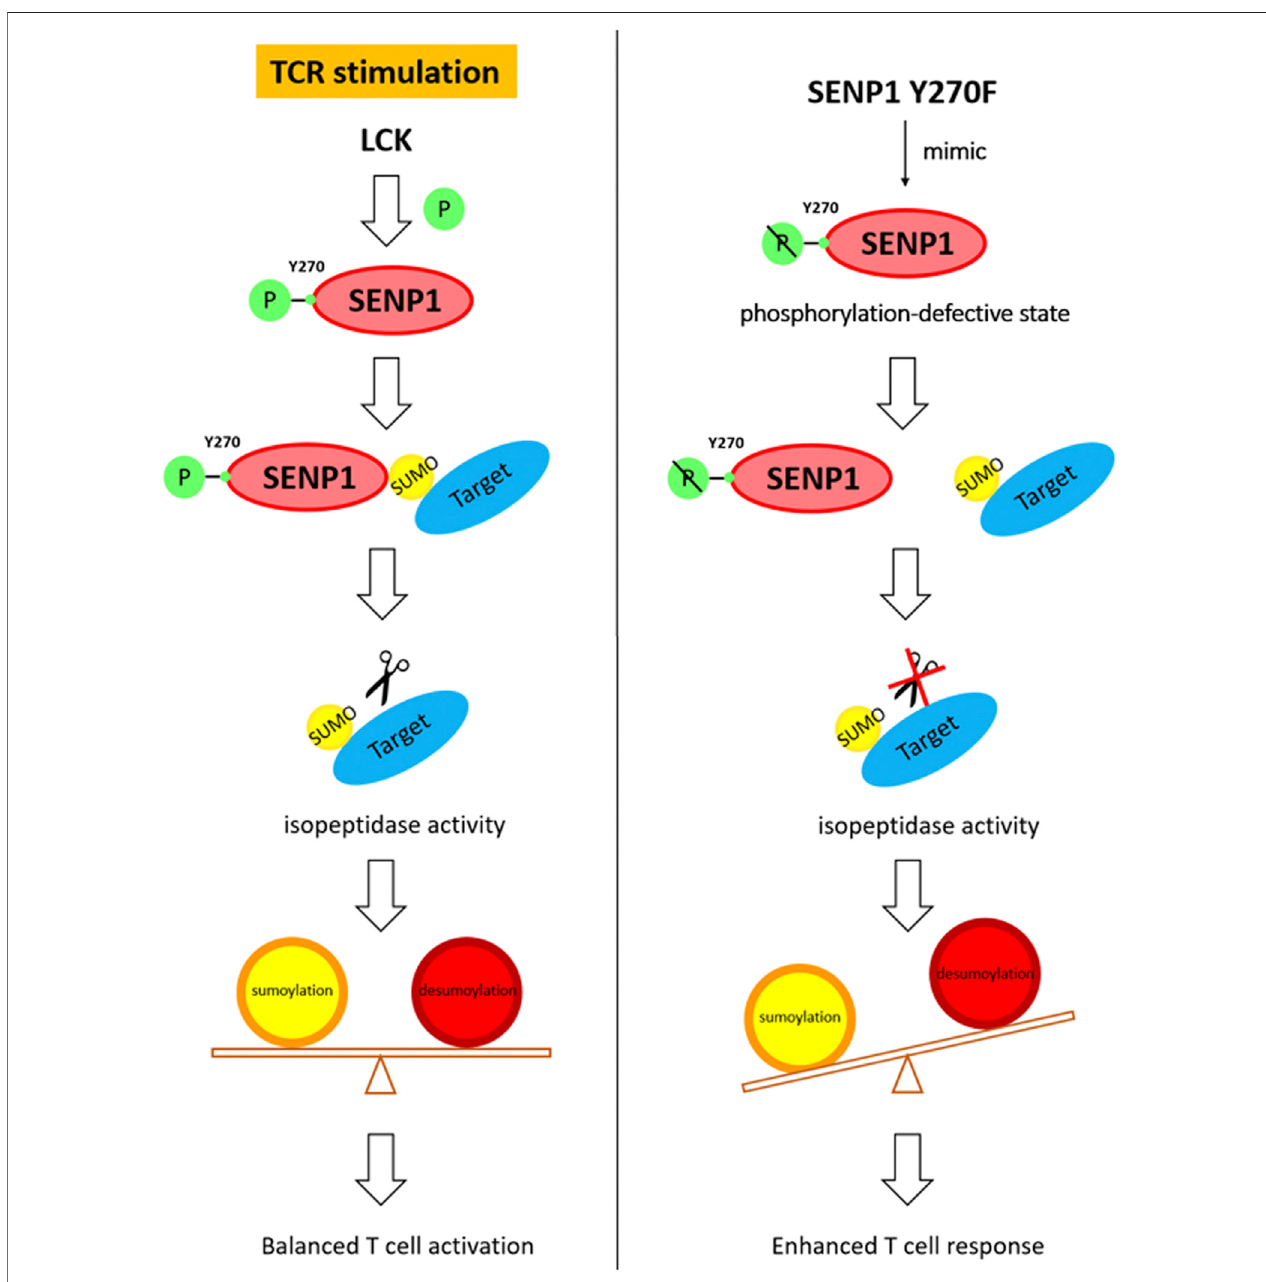
FIGURE 7 | Working model for the regulatory function of SENP1 Y270 phosphorylation.